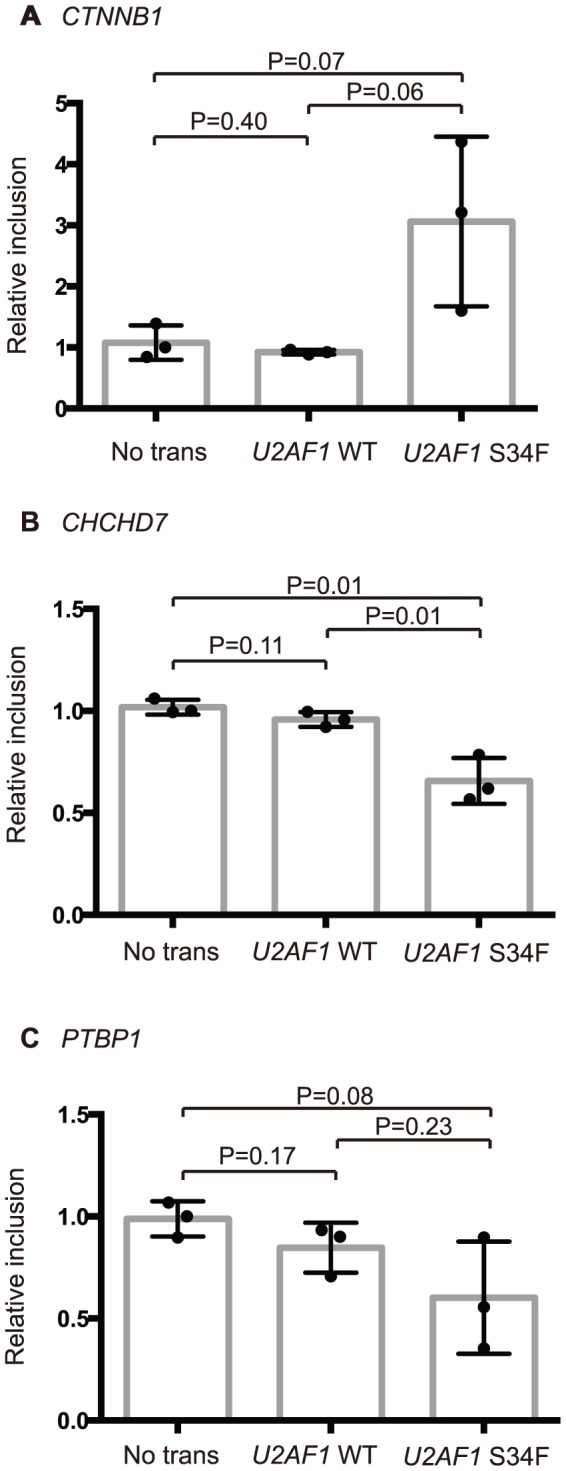
Quantitative RT-PCR validation of splicing events affected by expression of U2AF1 S34F in 293T cells.A fold difference between total gene expression and the inclusion isoform of each splicing event was normalized by the fold difference of a no-transfection control sample to yield a relative inclusion level for each sample. The genomic coordinates of tested splice events in (A) CTNNB1, (B) CHCHD7, and (C) PTBP1 are given in Table 1.